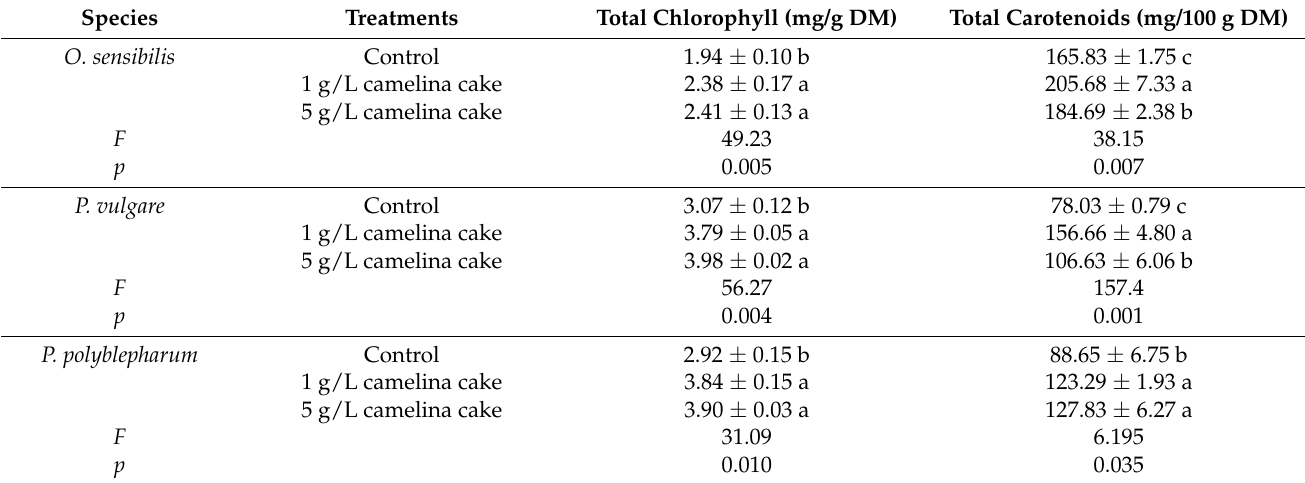
Table 3. The effect of amending peat substrate with camelina cake pellet on leaf photosynthetic pigment content of three species of hardy